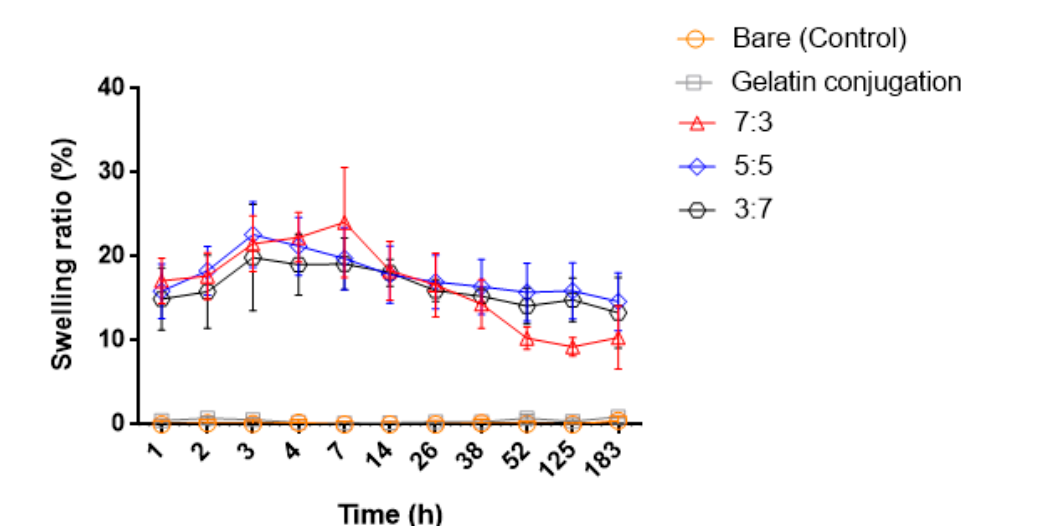
Figure 6. Comparison of swelling and degradation ability between bare, gelatin-conjugated poly(dimethylsiloxane) (PDMS), and PDMS coated with hydrogels with CHO–HA/Gel–NH 2 ratios of 7:3, 5:5, and 3:7 over time.